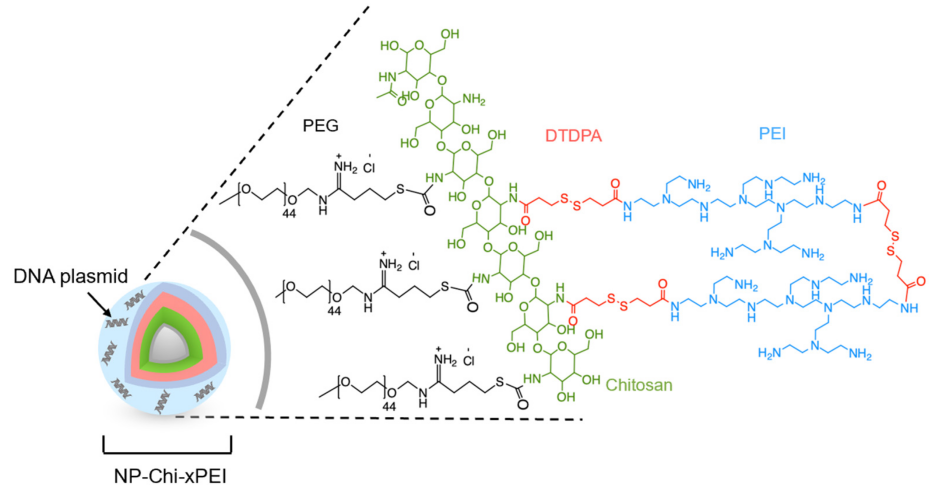
Figure 3. Schematic representation of NP − Chi − xPEI complexed with DNA with the zoom − in details of the structure of the Chi − xPEI polymer conjugated onto the surface of NP. Reprinted with permission from Ref. [120]. 2022, Molecular Diversity Preservation International.